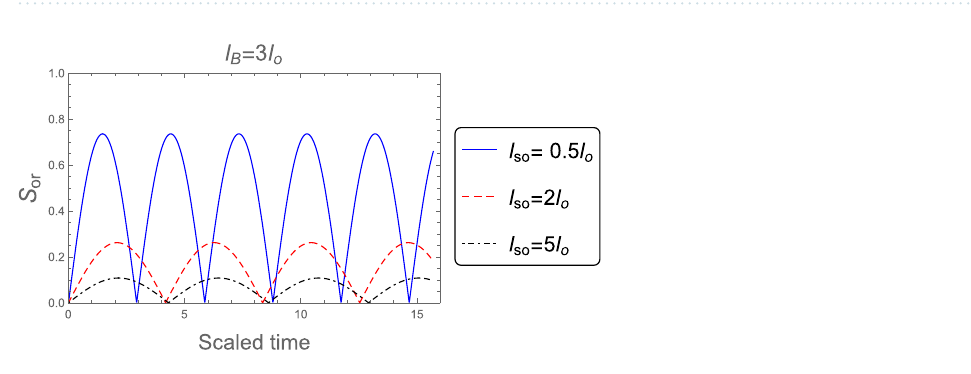
3 l o is applied. =